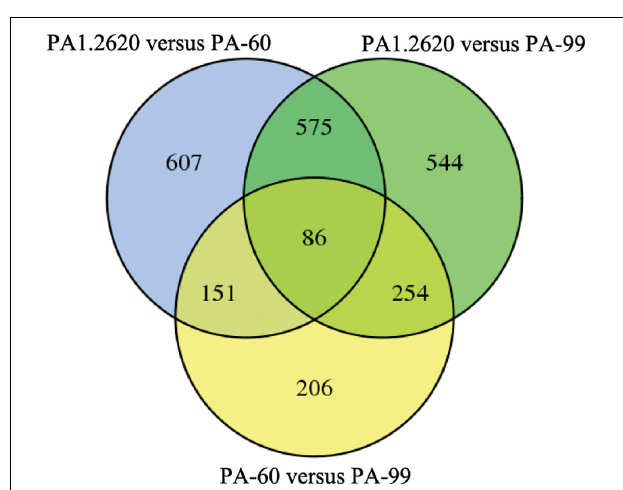
FIGURE 2 | Venn diagram of DGEs in different treatments. Venn diagram represents the number of DGEs and overlap between comparison groups. The sum of the numbers in each large circle represents the total number of differential genes in the comparison. The overlapped part of the circle represents the common differential genes between the